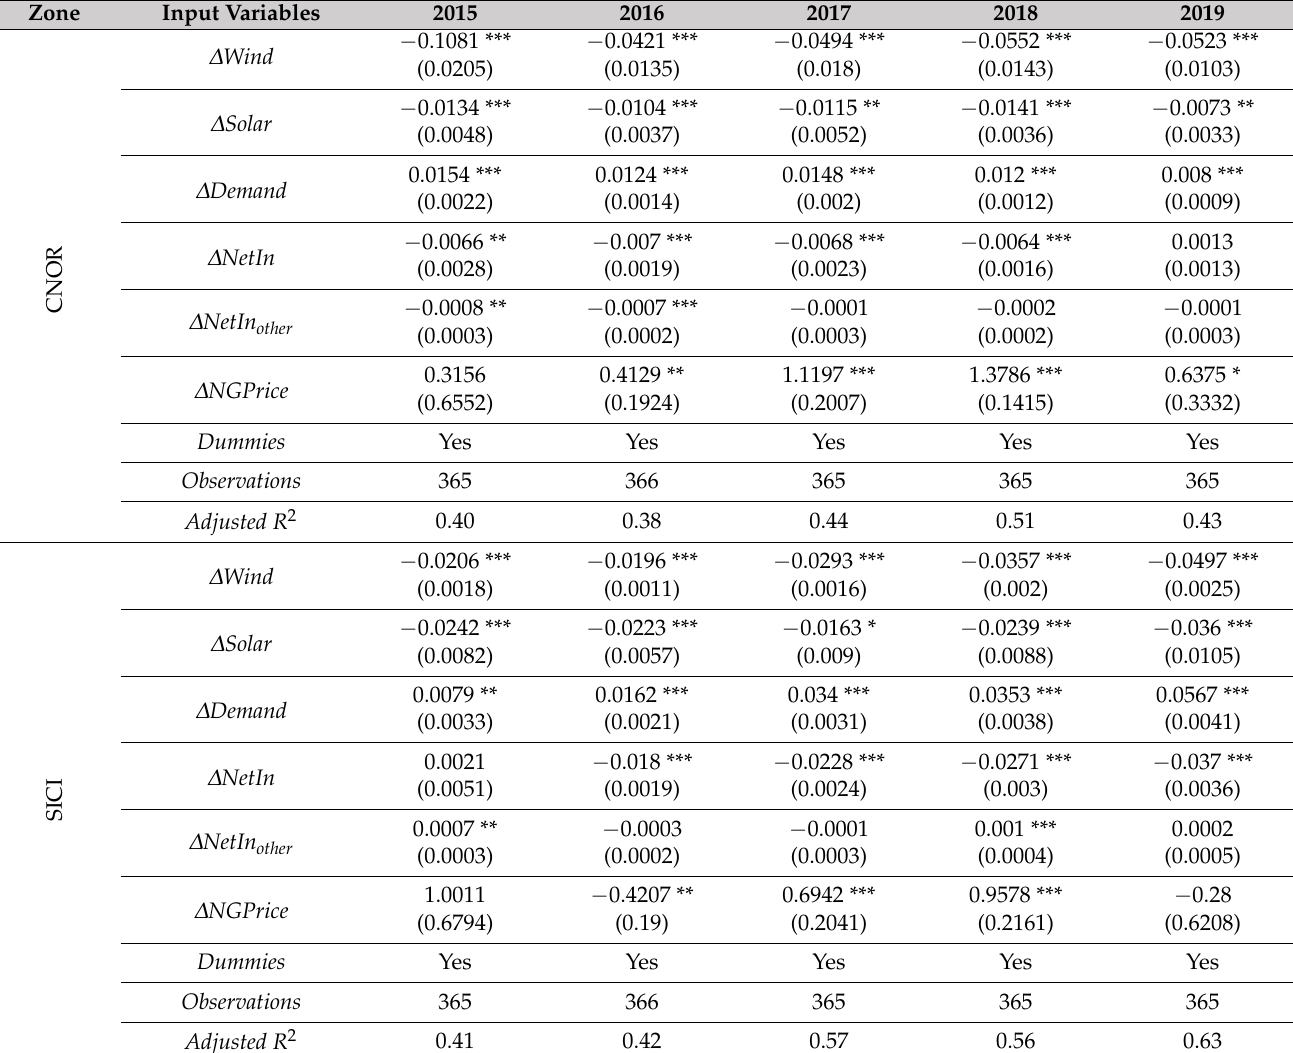
Table 2. OLS estimation of daily changes in electricity prices of CNOR; results of Equation (3).